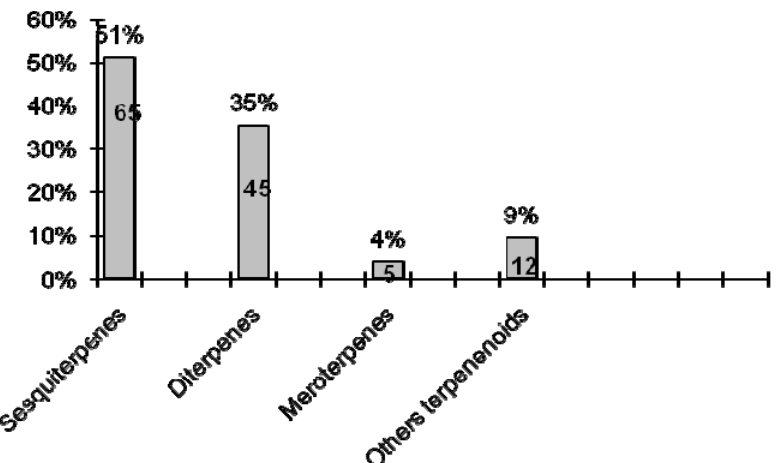
Figure 5. Amount and percentage of the isolated